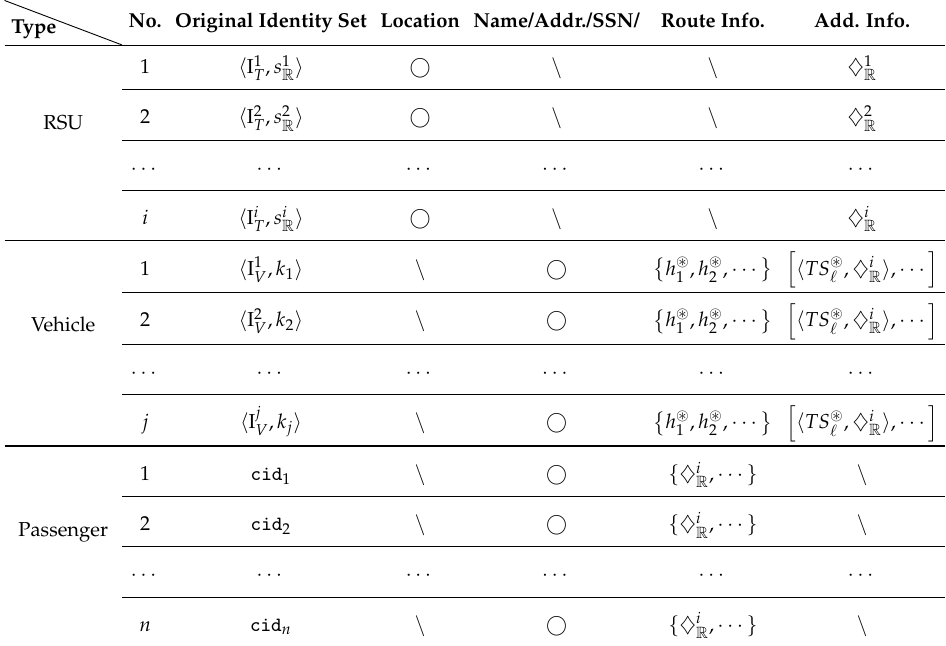
Table 2. Data Structure of Vehicular Records for Registered